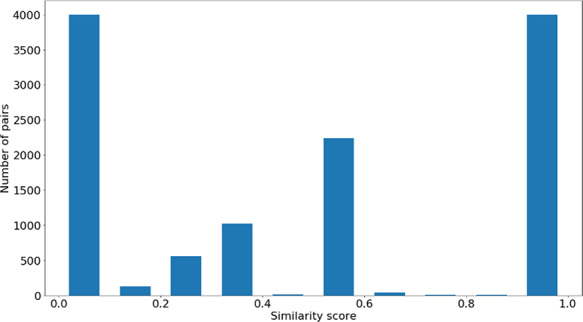
Distribution of \documentclass[12pt]{minimal}
\usepackage{amsmath}
\usepackage{wasysym}
\usepackage{amsfonts}
\usepackage{amssymb}
\usepackage{amsbsy}
\usepackage{upgreek}
\usepackage{mathrsfs}
\setlength{\oddsidemargin}{-69pt}
\begin{document}
}{}$si{m_{PS}}$\end{document} values across all the pairs in the gene-phenotypes data sets.